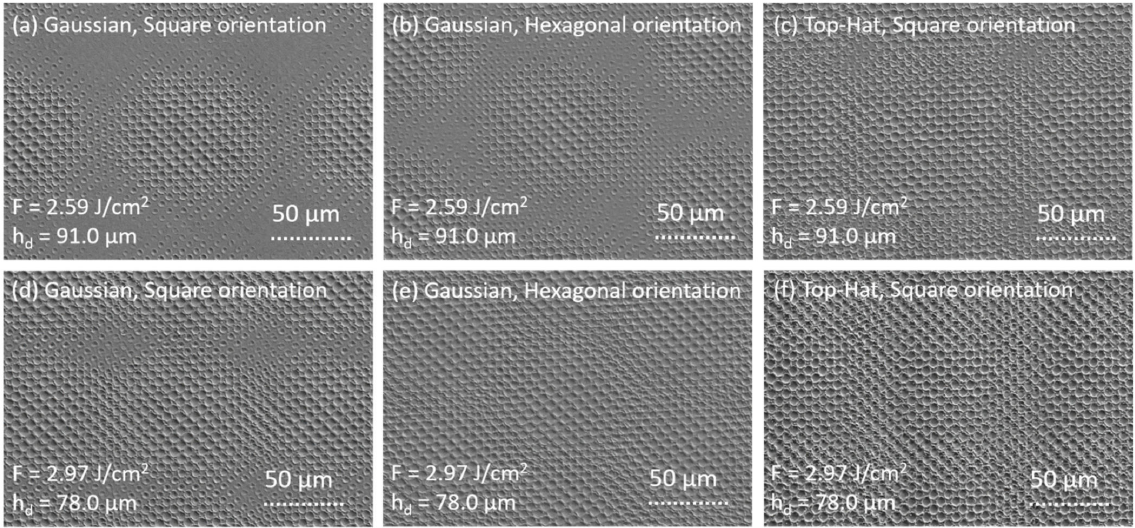
Figure 5. Scanning electron microscope (SEM) images of textured surfaces using the nanosecond four-beam DLIP configuration, produced on 1.4301 steel. The spatial period Λ 4 was 6.50 µ m and the following process parameters were used: ( a – c ) F = 2.59 J/cm 2 , h d = 91.0 µ m; ( d – f ) F = 2.97 J/cm 2 , h d = 78.0 µ m. The patterns were produced using ( a , c , d , f ) the square and ( b , e ) hexagonal